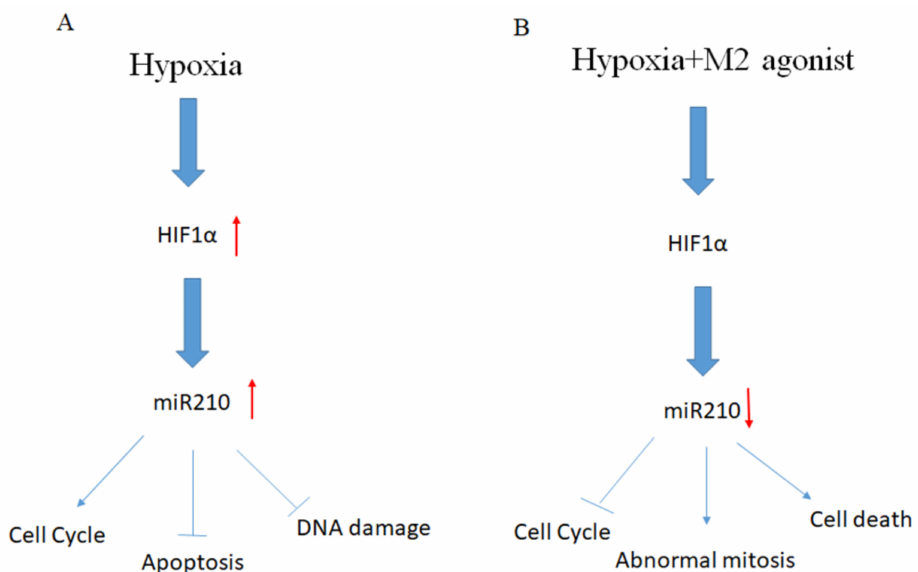
Figure 8. Schematic representation of the mechanisms activated in hypoxia in GSC maintained in absence ( A ) or in presence of M2 agonist Ape ( B ). Hypoxia upregulating HIF1 α and miR210, promote cell survival, cell cycle progression and protects the GCSs from apoptosis and DNA damage ( A ). The treatment of GSCs with orthosteric agonist for M2 muscarinic receptor, de-regulates the adaptative responses of the cells to the hypoxic stress, causing the downregulated expression of miR210 and (PGRN), the arrest of the cell cycle progression, the increase of abnormal mitosis and decreased cell survival ( B